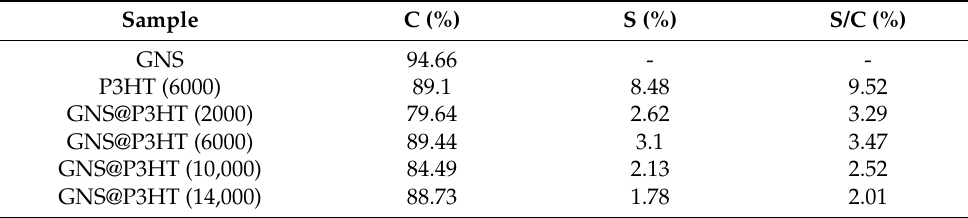
Figure 4. ( a ) X-ray photoelectron spectrometry (XPS) spectra of Graphene sheets (GNS), P3HT (6000) and GNS@P3HT with different molecular weights. ( b ) C1s spectrum of XPS of GNS. ( c ) C1s spectrum of XPS of P3HT (6000). ( d ) C1s spectrum of XPS of GNS@P3HT (2000). ( e ) C1s spectrum of XPS of GNS@P3HT (6000). ( f ) C1s spectrum of XPS of GNS@P3HT (10,000). ( g ) C1s spectrum of XPS of GNS@P3HT (14,000). Table 2. Relative atomic percentage of GNS, P3HT(6000), and GNS@P3HT samples.